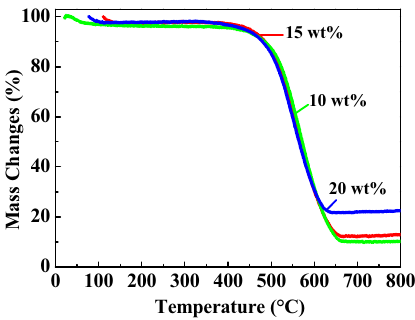
Figure 4: TG curves of Si@CNF with various